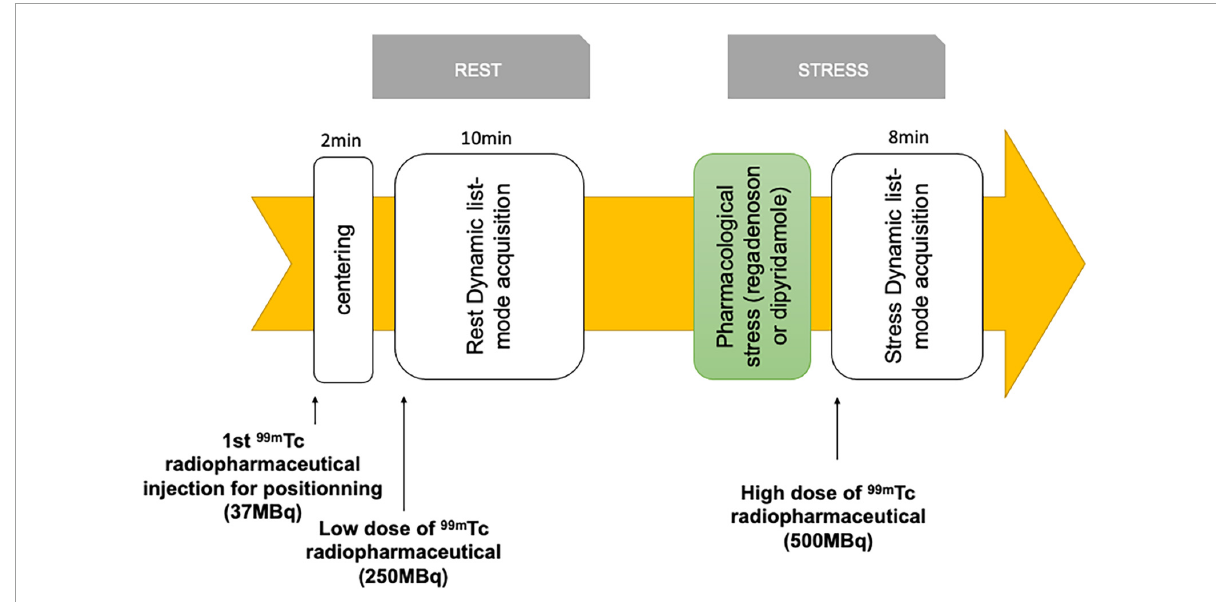
FIGURE2 Dynamic scintigraphy